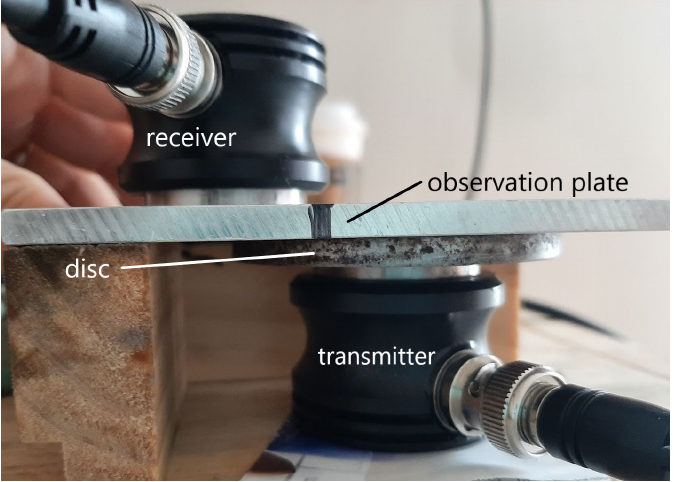
Figure 3. Data Collection—here, from top down, the receiver, observation plate, specimen, and trans- mitter can be seen. The wires connected to these components are attached to a computer to monitor the signals being transmitted and